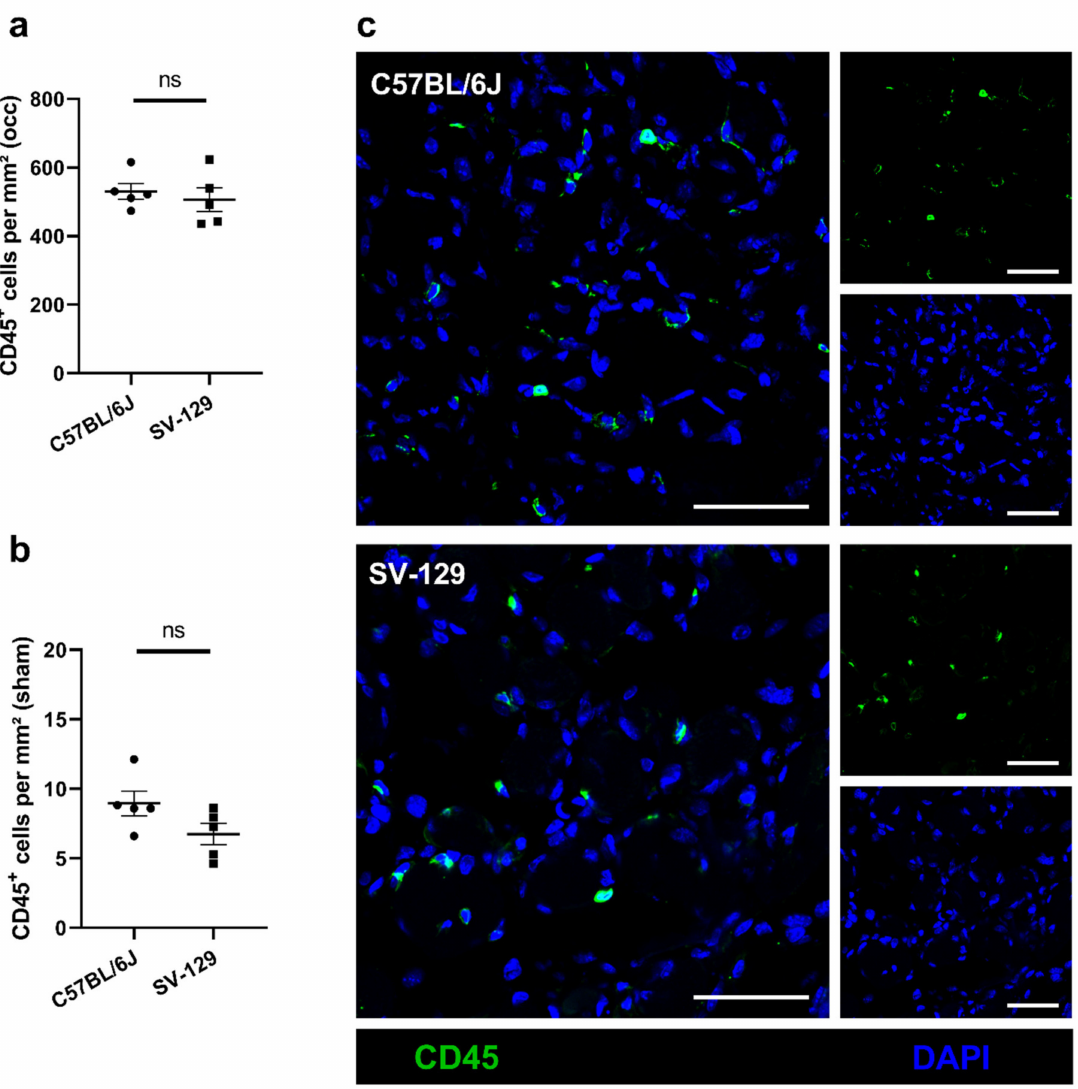
Figure 3. C57BL/6J and SV-129 mouse strains show comparable leukocyte accumulation under ischemic conditions. The scatter plots display ( a ) the number of infiltrating leukocytes (CD45 + /DAPI + ) per mm 2 in occluded (occ) ischemic gastrocnemius muscles of C57BL/6J and SV-129 mice as well as ( b ) the number of leukocytes per mm 2 in sham-operated (sham) non-ischemic tissue, all collected 7 days after femoral artery ligation (FAL). A defined ischemic area (1.5 mm 2 ) of muscle tissue was analyzed per mouse. Data are means ± S.E.M., n = 5 per group. n.s. p ≥ 0.05, ( C57BL/6J vs. SV-129 ) by unpaired, two-sided Student’s t -test. ( c ) Representative immunofluorescence staining of ischemic gastrocnemius muscles of C57BL/6J (top) and SV-129 mice (bottom) isolated 7 days after FAL. Cells were stained with an antibody against CD45 (green) and DAPI (blue) to label nucleic DNA. Scale bars: 50 µ